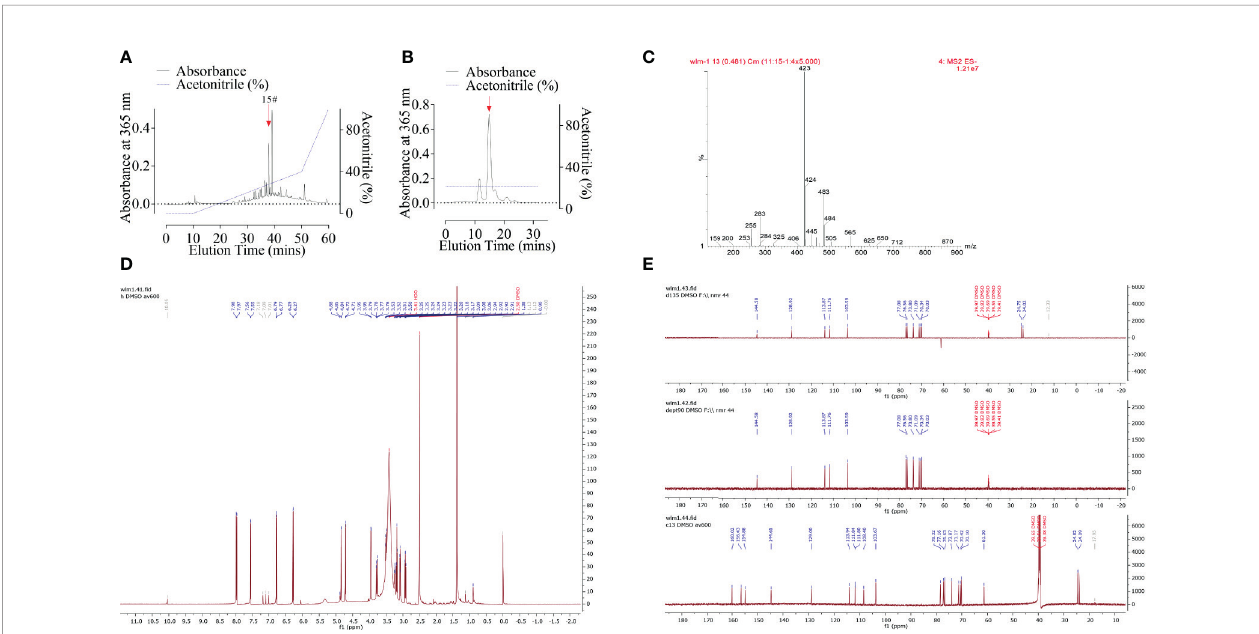
FIGURE 1 | Puri fi cation and characterization of anticarin b from Antiaris toxicaria . (A) Crude extract containing anticarin b was separated by a C 18 column and absorbance at 365 nm was recorded. (B) Fractions containing anticarin b (indicated by arrow in A) was further puri fi ed by a C 18 reverse phase (HPLC) column and the anticarin b was indicated by a red arrow. (C – E) Anticarin b was characterized by ESI-MS spectrum (C) , 1 H-NMR spectrum (DMSO, D), and 13 C DEPT NMR spectrum (DMSO,